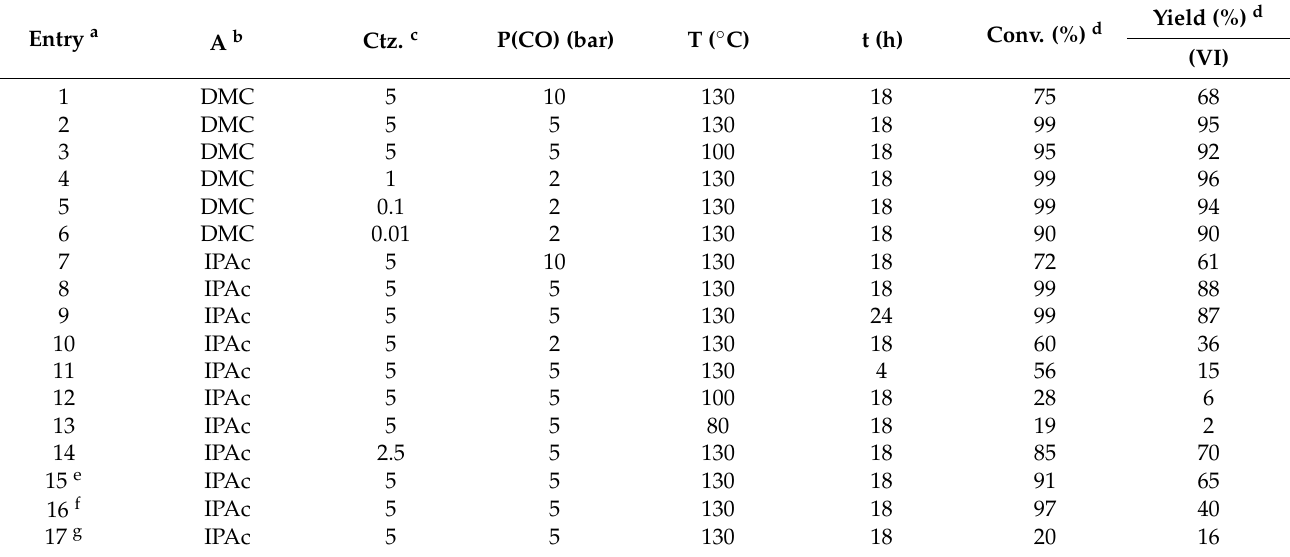
Table 2. One-pot methoxycarbonylation of piperonyl alcohol ( V ).